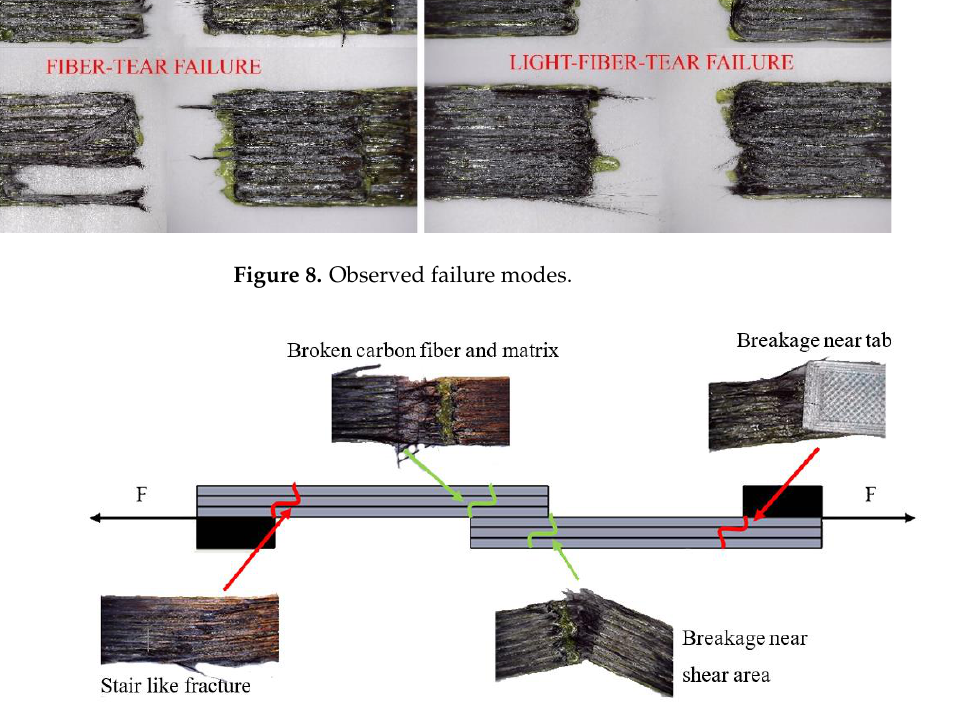
Figure 8. Observed failure modes .